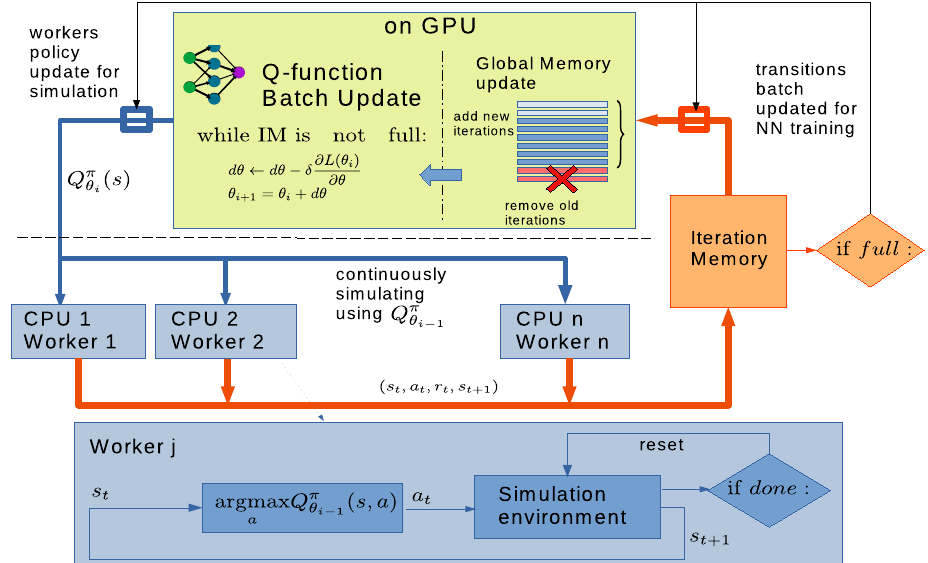
Figure 6. Schematic representation of the multi-node asynchronous DQL algorithm. The upper part of the diagram (NN update) and the lower (agents simulations) are performed in parallel on different nodes, at the end of each iteration, data is shared (NN coefficients from the updater node and transitions memory from the simulating